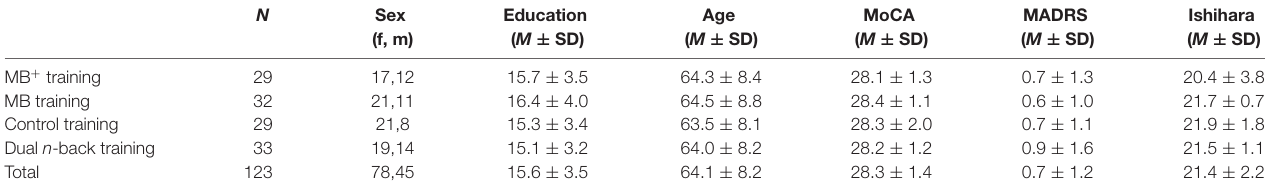
TABLE 2 | Demographic characteristics of the included sample at prebaseline. N